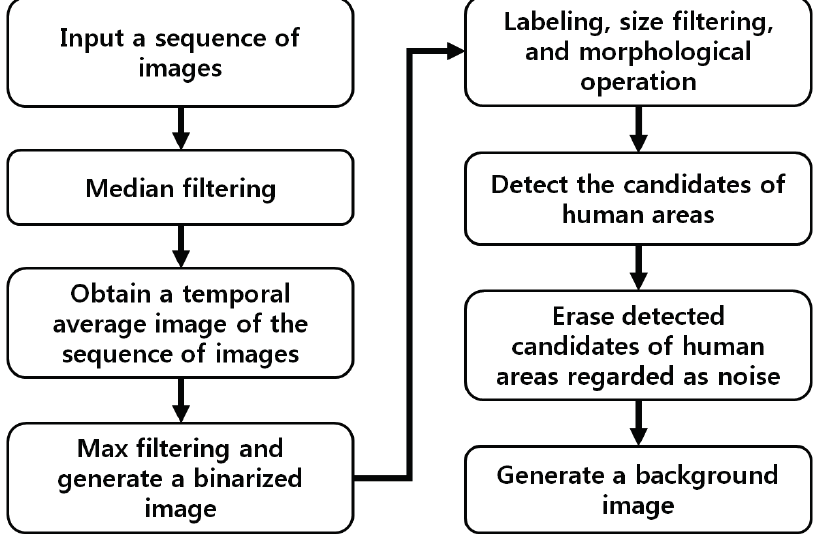
Figure 2. Flow chart of generating a background